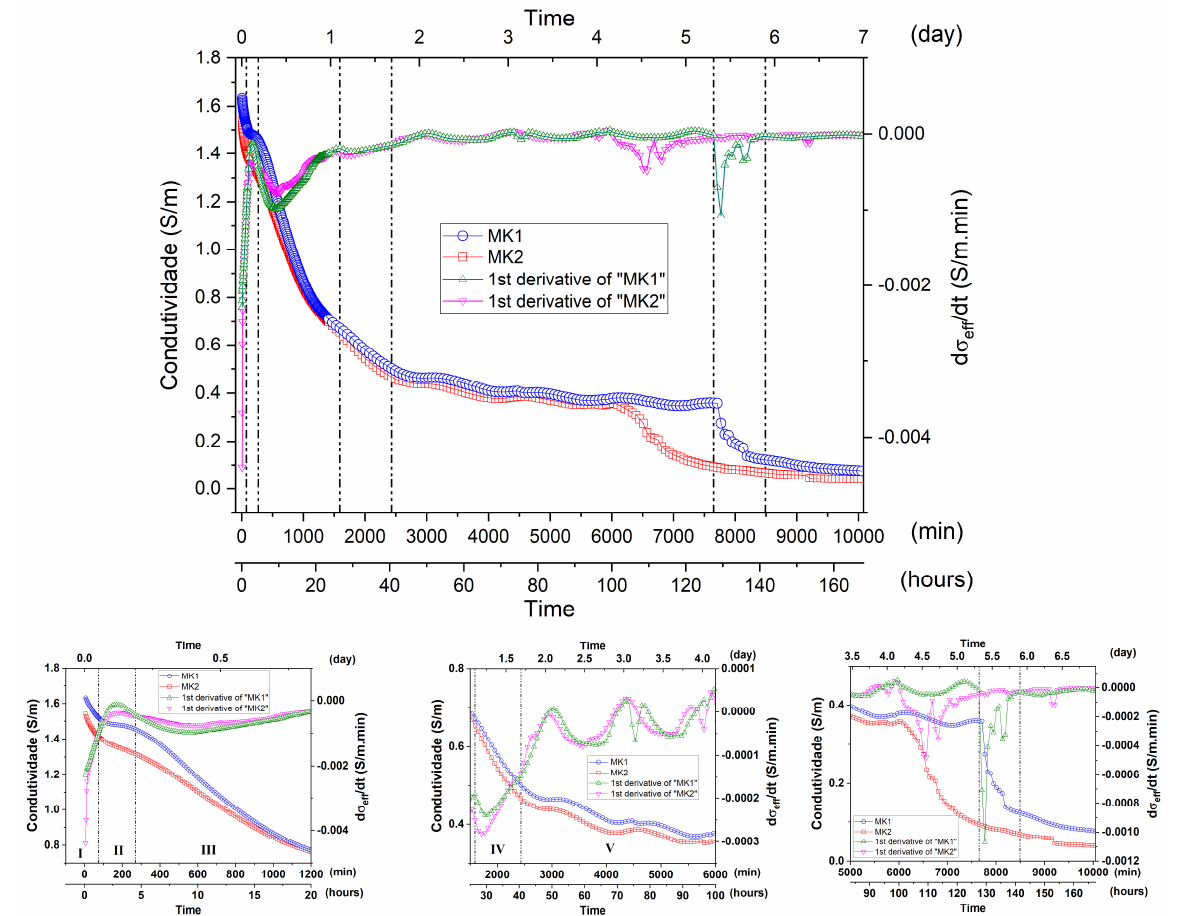
Figure 10. Electrical conductivity, σ, and its derivative, dσ/dt, as a function of the geopolymerization time for samples MK1 and MK2. Insets: comparative curves of the I–VII regions.